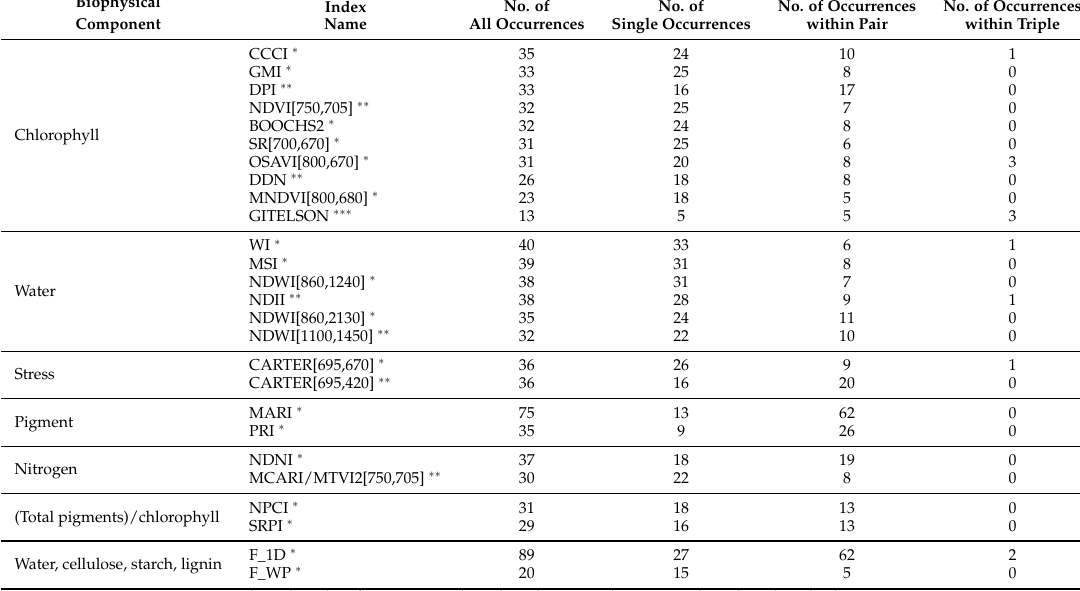
Table 11. Single selected indices from the Hellinger distance and their occurrences.